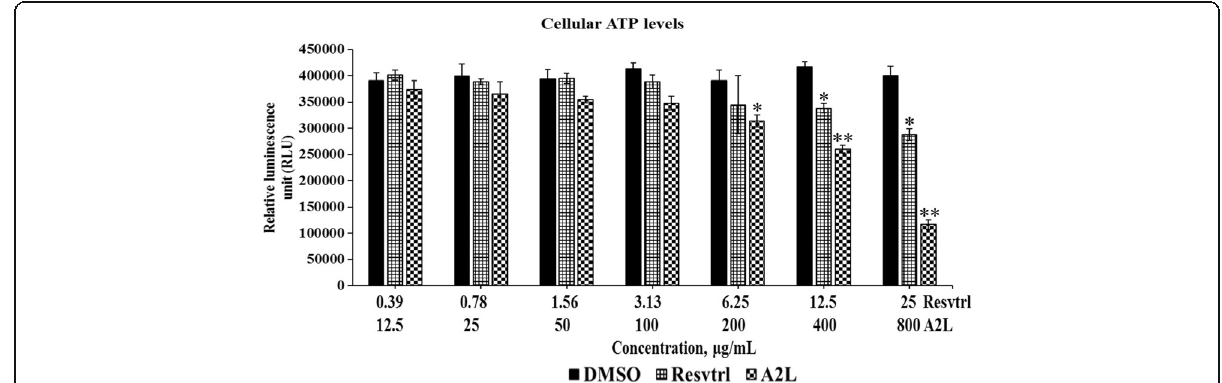
Fig. 8 Effects of treatment on ATP levels. Variations in ATP status of HepG2 cells treated with resveratrol or A2L. * p < 0.05; ** p <